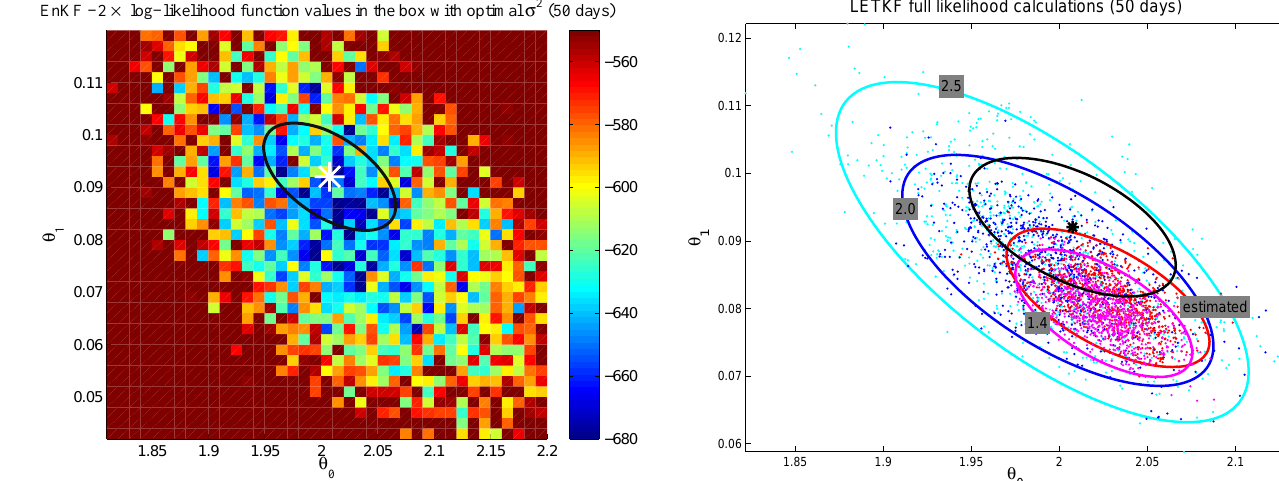
Fig. 10. Full likelihood calculations using LETKF data assimilation method. Different MCMC runs with different covariance inflation factor together with 95% trust ellipses. Red color indicates a run, where the factor is also estimated (mean value is 1.52). Magenta, blue and cyan colors indicate a run where covariance inflation factor is fixed to 1.4, 2.0 and 2.5, respectively. Black star and ellipse is acquired from correspondent EKF likelihood